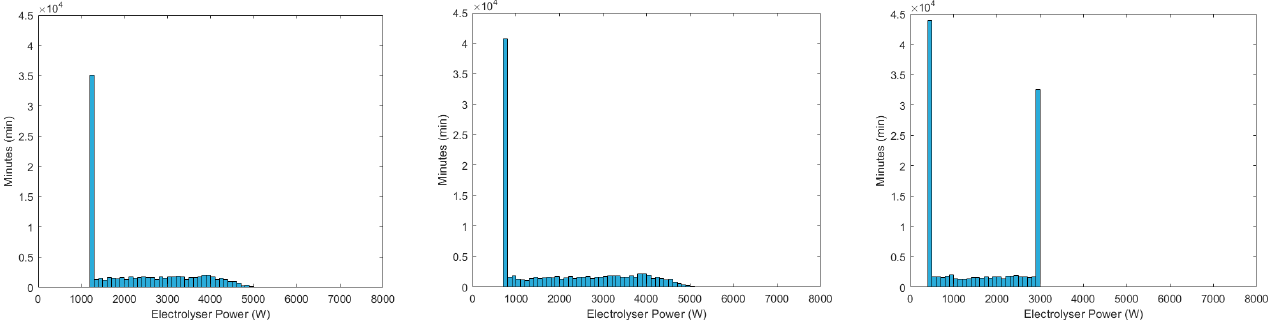
Figure 16. Histograms of the power distributions under different ELY dimensionings (5 kW ( left ), 3 kW ( middle ) and 2 kW nominal power ( right )).